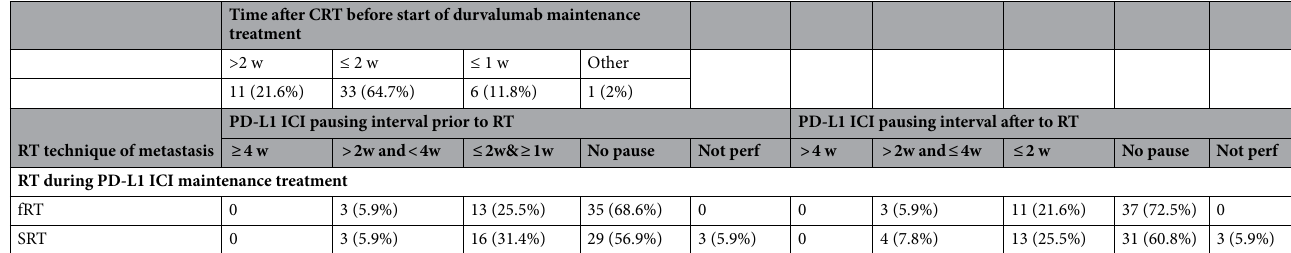
and 29.4% (15/51) less than 2 weeks after. A minority of participants pause between 2 and 4 weeks prior and after brain radiation with almost no difference between the radiation techniques. Thorax. For radiation treatment in the central thoracic region close to central bronchi, the heart or esophagus the majority do not suspend ICI prior (51.0% [26/51]) and after (52.9% [27/51]) nfRT or prior (37.3% [19/51]) and after (45.1% [23/51]) SRT. Compared to brain radiation more treating physicians (11.8% [6/51]) tend to pause ICIs longer (between 2 and 4 weeks) prior to radiation regardless of the fractionation schedule. Compar- ing pausing intervals for central and peripheral thoracic region a greater percentage of participants indicated to pause ICI treatment for central thoracic region (49% [25/51] for nfRT and 52.9% [27/51] for SRT) as for periph- eral thoracic region (39.2% [20/51] for nfRT and 37.3% [19/51] for SRT).